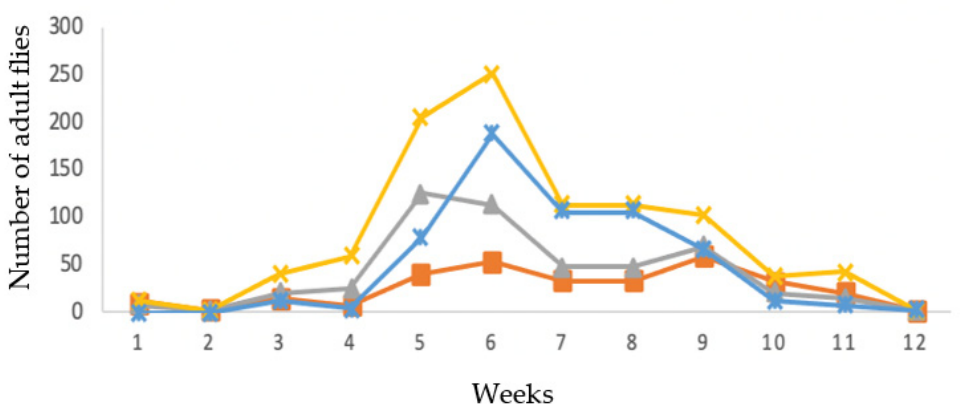
Figure 3. Effects of three mulching practices in comparison to unmulched control on the capture of D. suzukii in the blueberry field using Suzukii ® bait trap in 2017.